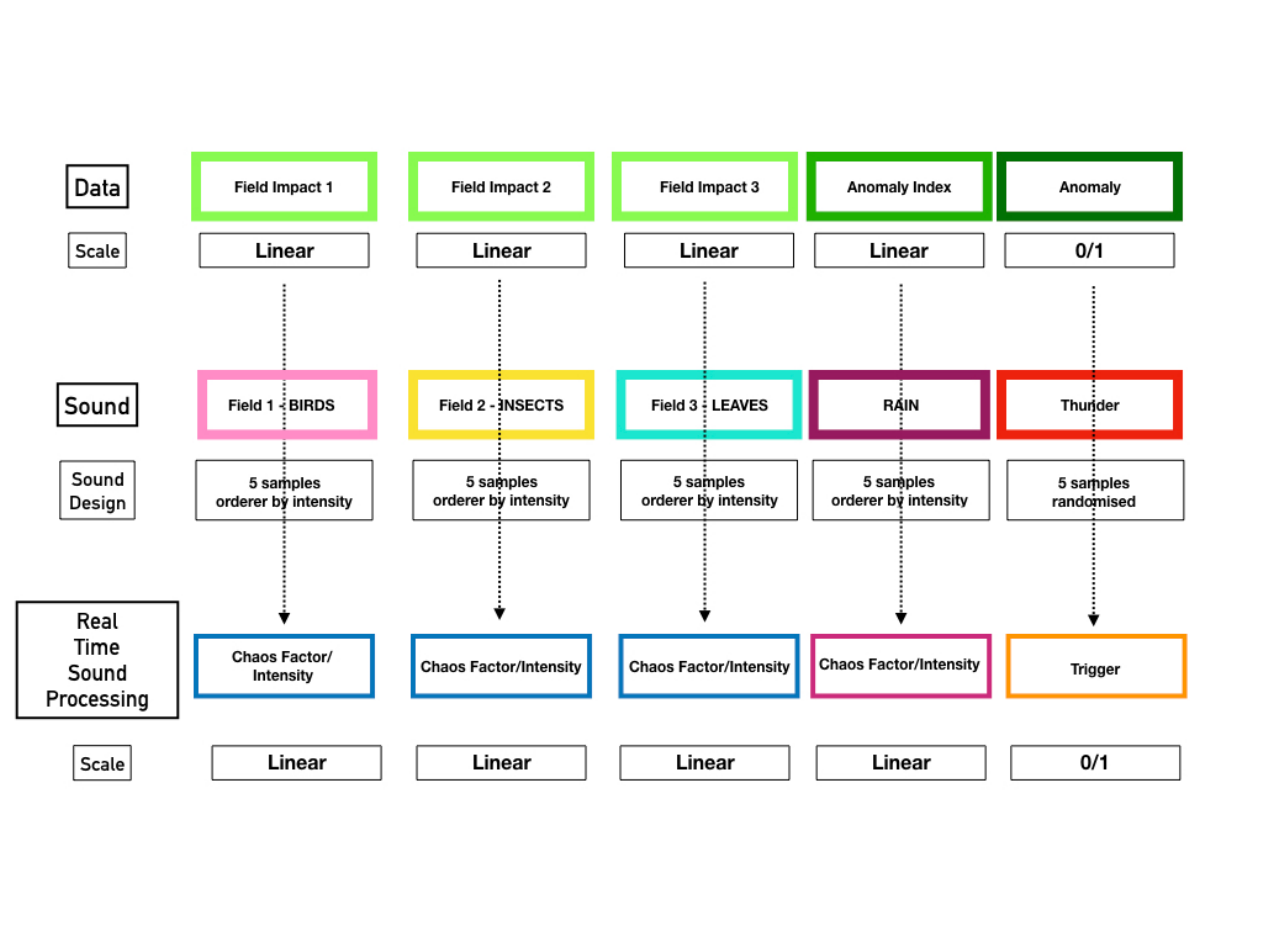
Figure 6 . Second Design Action. Data-to-sound mapping